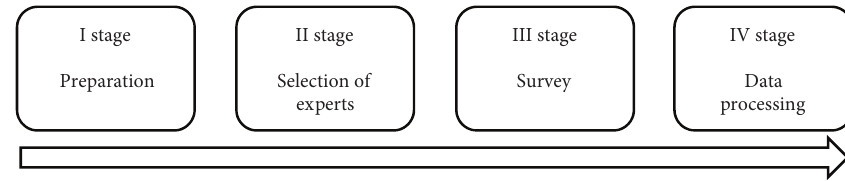
Figure 2. Research stages (compiled by the authors)